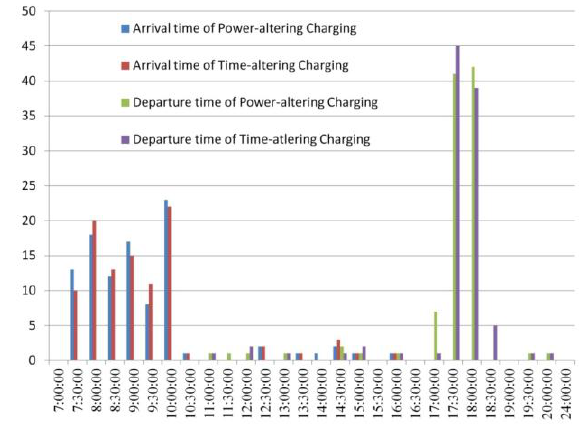
Figure 6. EV arrival and departure time for different charging control methods. Table 2. State of charge (SOC) distribution